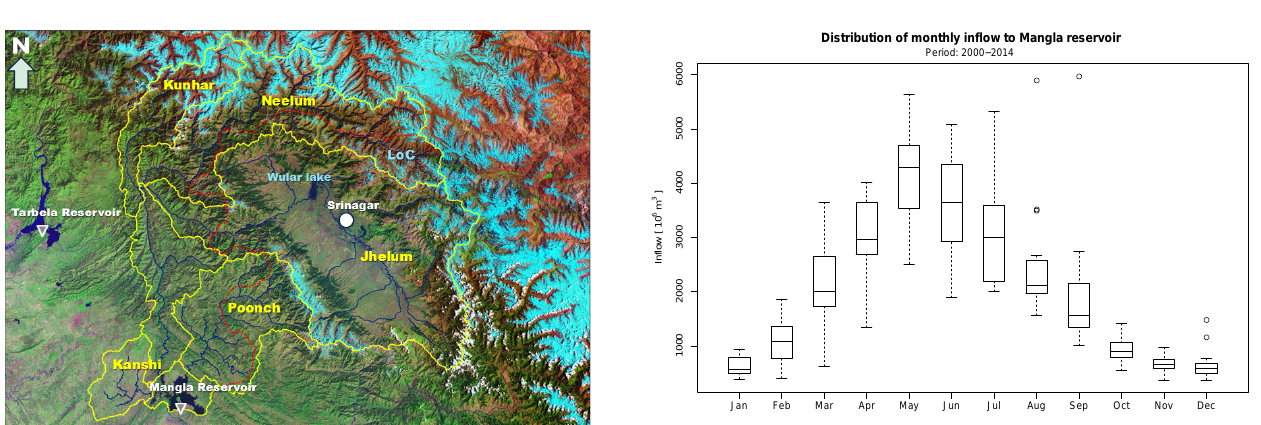
Figure 1. Landsat TM scene of study area.